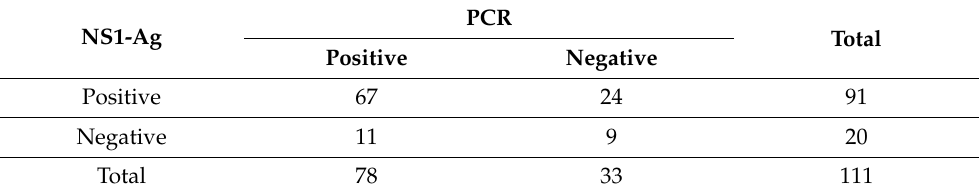
Table 2. Comparison of samples tested by DENV-NS1-Ag test compared to PCR results ( n = 111).